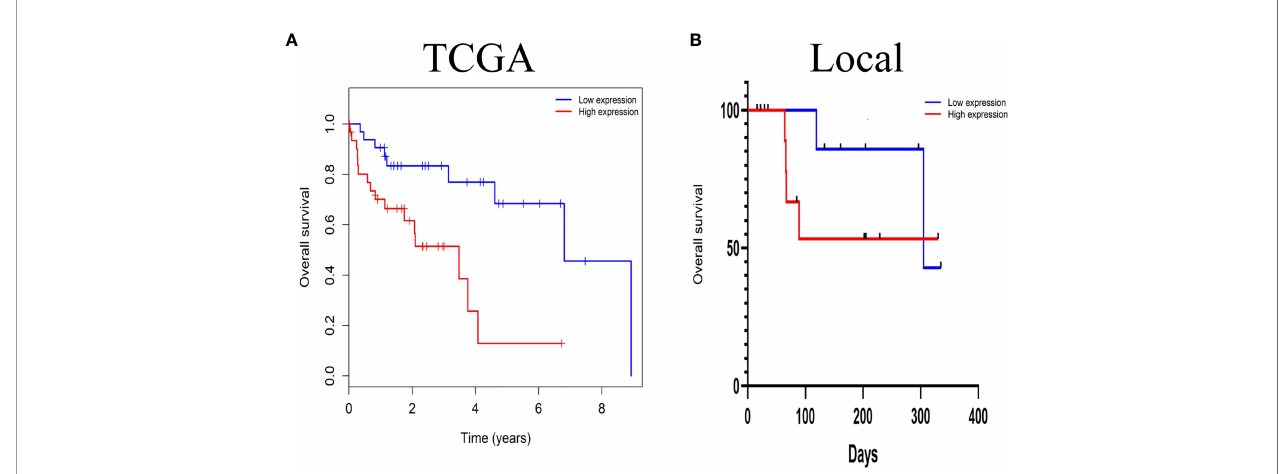
FIGURE 3 | The prognostic signi fi cance of LINC01667 in patients with HCC. (A) Kaplan – Meier curves showing the OS of patients with HCC according to high and low LINC01667 expression in a TCGA cohort (n = 374). (B) Kaplan – Meier curves showing the OS of patients with HCC according to high and low LINC01667 expression in the local cohort (n = 20).